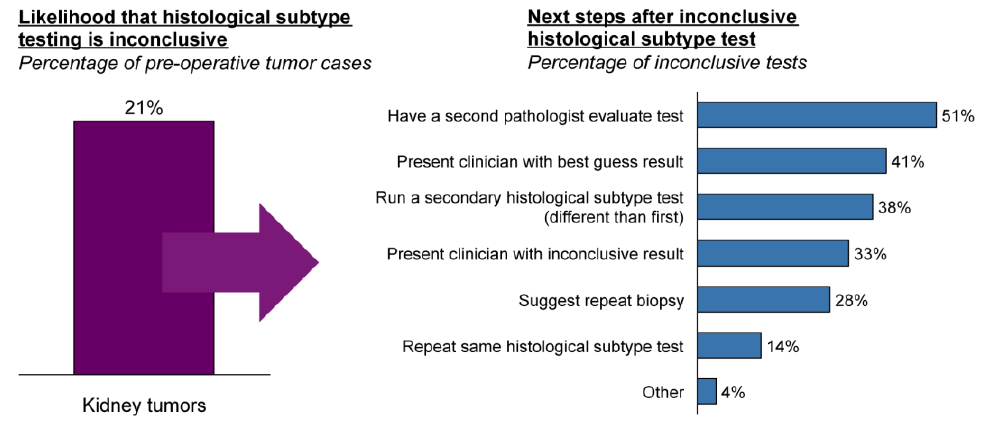
Figure 7. Pathologist responses to inconclusive